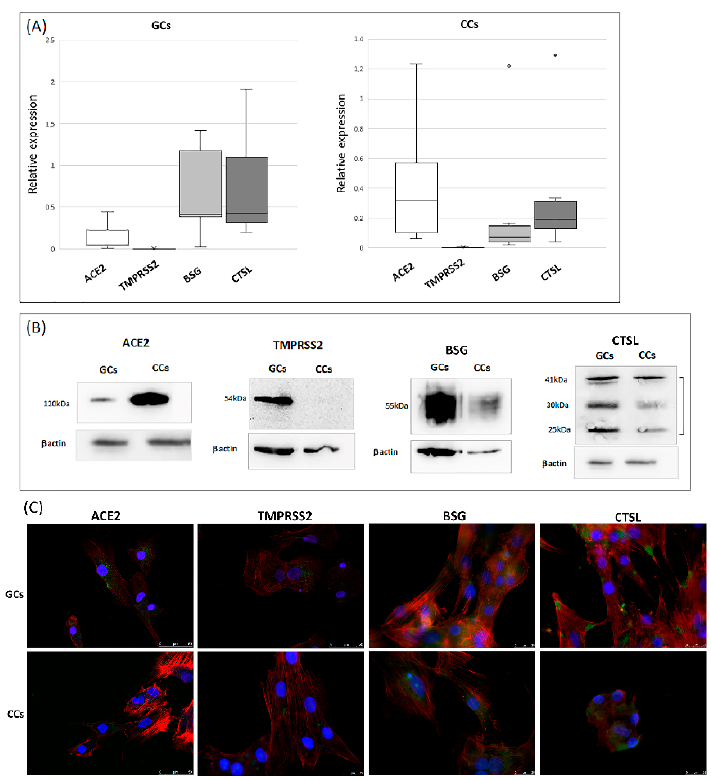
Figure 1. Expression and localization of ACE2 and its proteases in human GCs and CCs. ( A ) mRNA expression of ACE2, TMPRSS2, BSG and CTSL in human granulosa and cumulus cells. Graphical diagrams are plotted as box–whisker plots, where boxes show the interquartile range with median values, and whiskers represent min and max. Number of analyzed samples: GCs: 16, CCs: 16. ( B ) Western blot of ACE2, TMPRSS2, BSG and CTSL in human GCs and CCs. Western blots were repeated twice on a pool of 5 patients for each group, with comparable results. Equal protein loading of the two preparations was verified using the housekeeping beta-actin. ( C ) Representative micrographs (from three independent experiments) of immunofluorescence staining and confocal microscopy for SARS-CoV-2 host receptor ACE2 and TMPRSS2, BSG, CTSL proteases in human GCs and CCs. ACE2, TMPRSS2 and BSG are in green, actin is in red, nuclei are in blue. Scale bar =